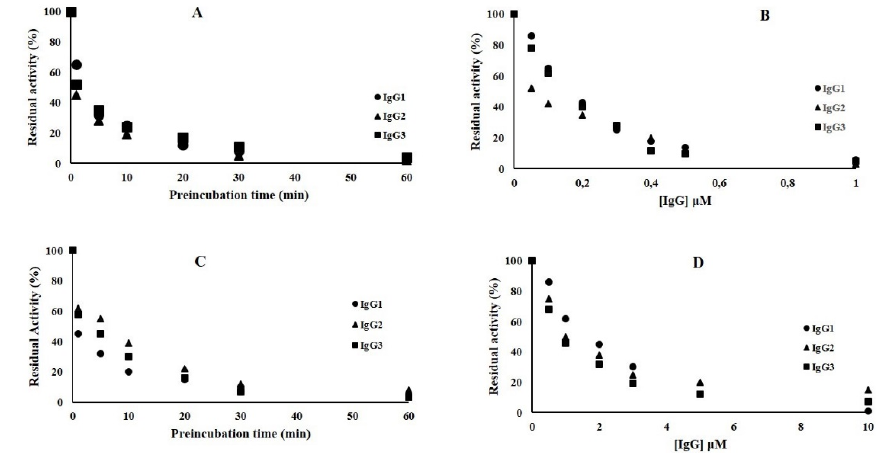
Figure 5. Inhibition effect of IgG1, IgG2, and IgG3 towardVerona integron ‐ encoded metallo ‐β‐ lactamase VIM ‐ 1 and L1 metallo ‐β‐ lactamase L1. ( A ) Time ‐ dependent inhibition assays of the three antibodies toward VIM ‐ 1 and L1; ( B ) residual activity (%) of VIM ‐ 1 after preincubation (1 min) with increasing concentrations of IgG1, IgG2, and IgG3; ( C ) time ‐ dependent inhibition assays of the three antibodies toward L1, ( D ) residual activity (%) of L1 after preincubation with increasing concentrations of IgG1 (1 min), IgG2 (5 min), and IgG3 (1 min). Each kinetic value is the mean of three different measurements; the standard deviation (SD) was below 2%.